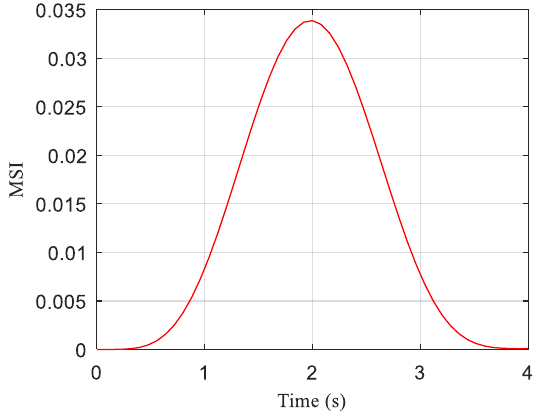
Figure 9. The real-time force/torque on the end effector of the humanoid manipulator. ( a ) Real-time force on the end effector; ( b ) Real-time torque on the end effector.